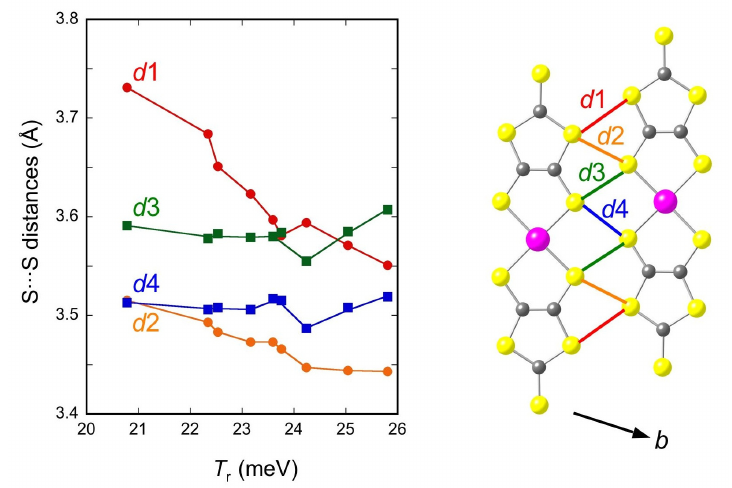
and intermolecular S···S distances (Å) responsible for T r